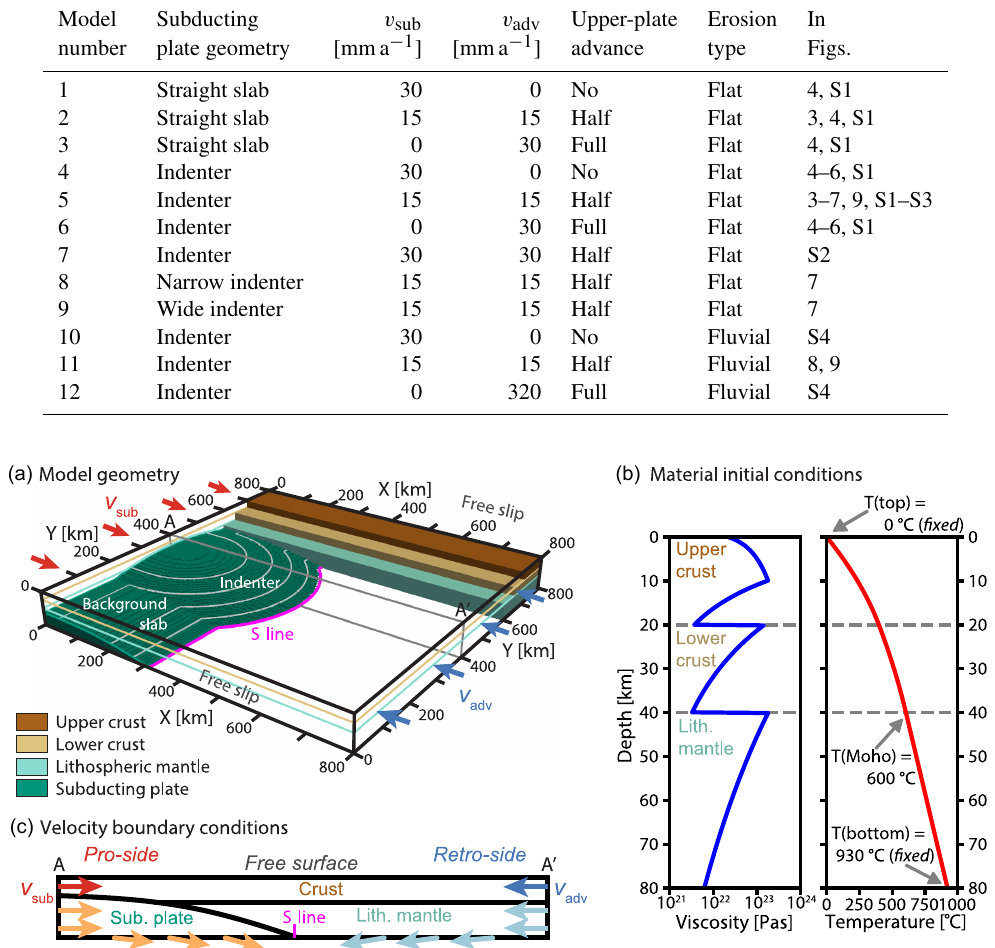
Table 1. Controlling parameters overview.